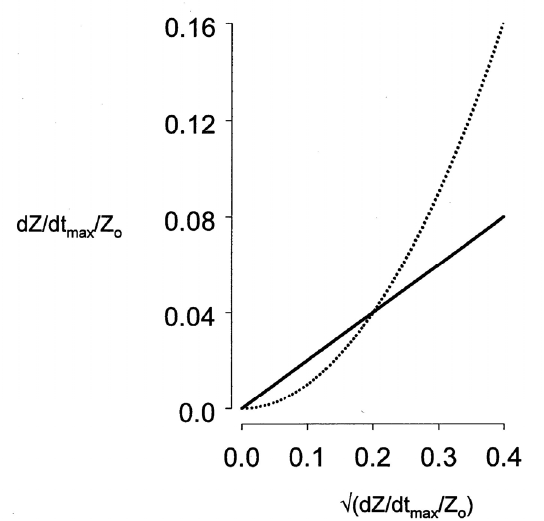
Fig. 9. Square root acceleration step-down transformation. On the y-axis, the ohmic equivalent of peak aortic reduced average blood acceleration (PARABA), which is dZ/dt max /Z 0 ., and the linear extrapolation of the square root transformation, ohmic mean velocity on the x-axis (x = √y and y = x 2 ). From reference